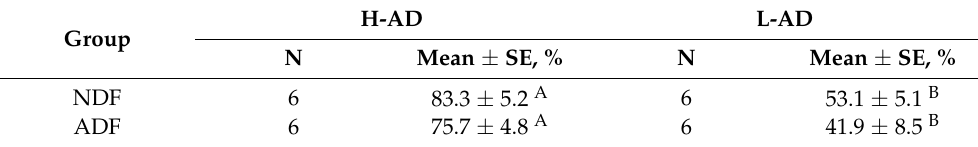
Table 2. Comparison of the ATTD of NDF and of ADF between H- and L-AD pigs. H-AD L-AD Group N Mean ± SE, % N Mean ± SE, %